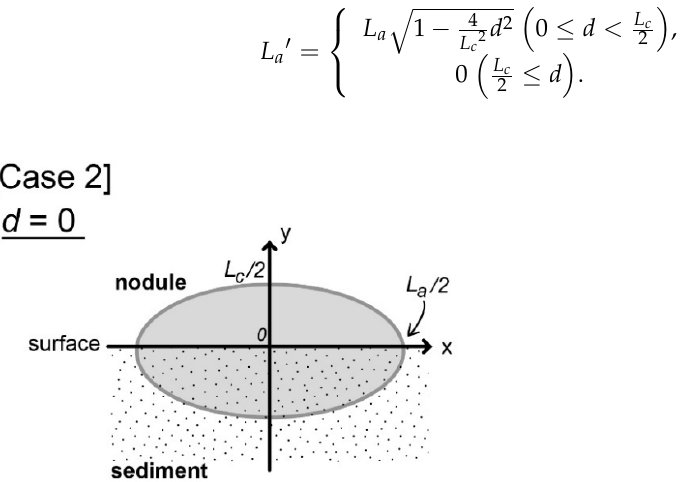
Figure 3. Schematic illustration of a cross section of a nodule and sediment that shows positional relations for Case 2. The nodule is half-buried into sediment under the initial condition.